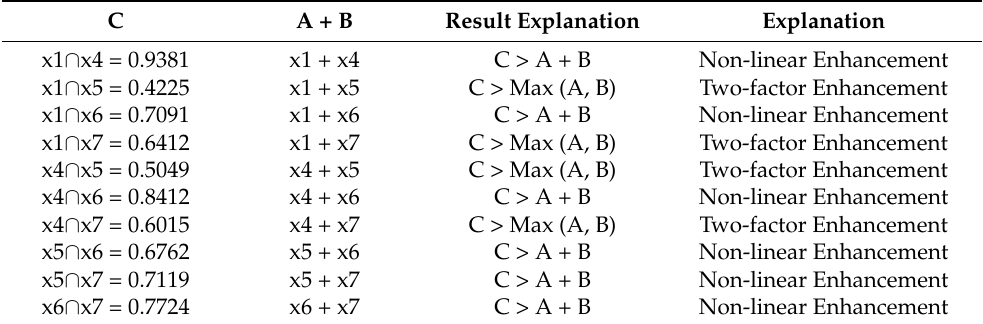
Table 5. Interactive exploration of the impact factors of land used for transportation at the county level in